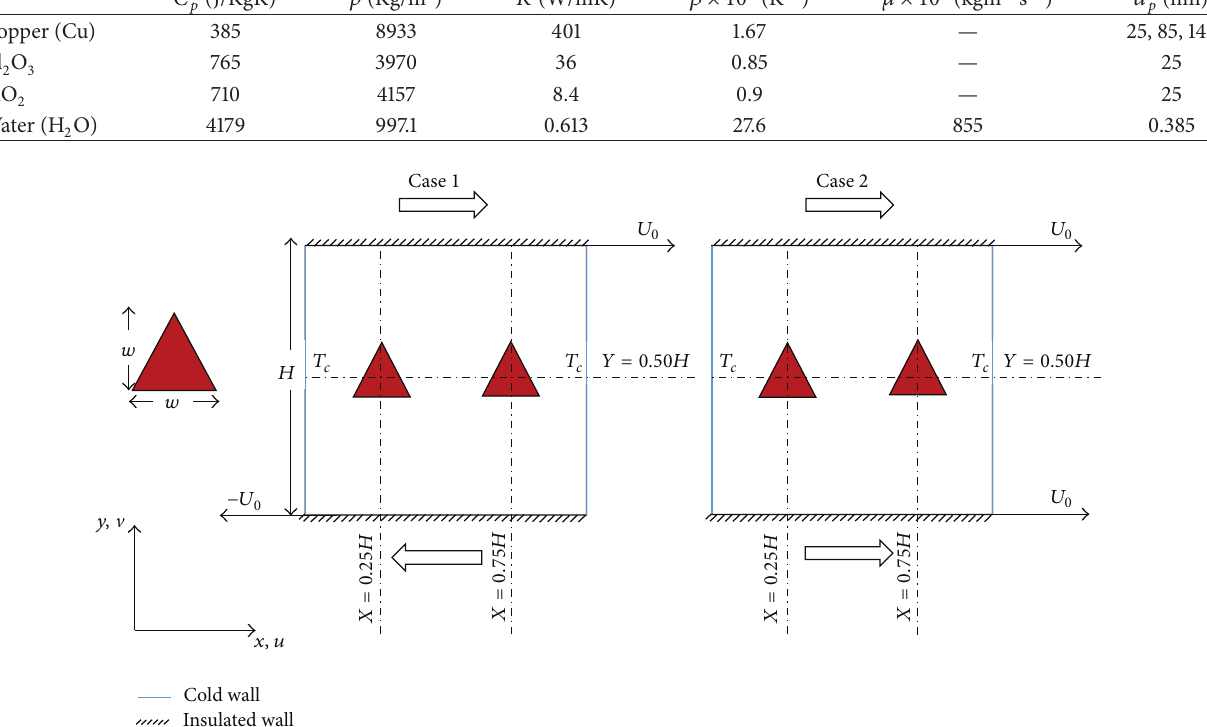
Figure 1: Schematic of the cavity with a pair of triangular heat sources and boundary conditions. Figure 1. It is a two-sided lid-driven square cavity with a pair of triangular heating cylinders, filled with nanofluids. The triangular heat source is maintained at a temperature 𝑇 ℎ = 310 K. The vertical walls are cooled at constant temperatures = 290 K. Two different cases were considered as shown in 𝑇 𝑐 Figure 1. In Case 1, the upper wall (adiabatic) is moving to the right while bottom wall (adiabatic) is moving to the left. In Case 2, the direction of the two moving walls is the same. It is assumed that the nanofluid is Newtonian, incompressible, and laminar and the base fluid and the nanoparticles are in a thermal equilibrium state. The thermophysical properties of the nanofluid used in this study are evaluated at the average fluid temperature (𝑇 𝑐 + 𝑇 ℎ )/2 as listed in Table